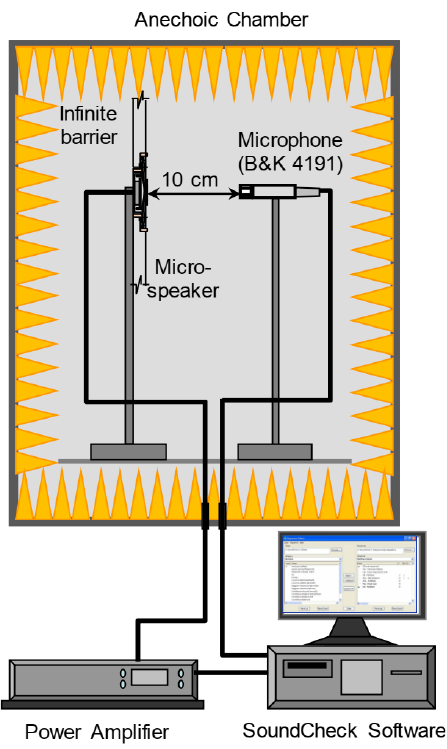
Figure 3. Schematic diagram of microspeaker on the barrier in an anechoic chamber.